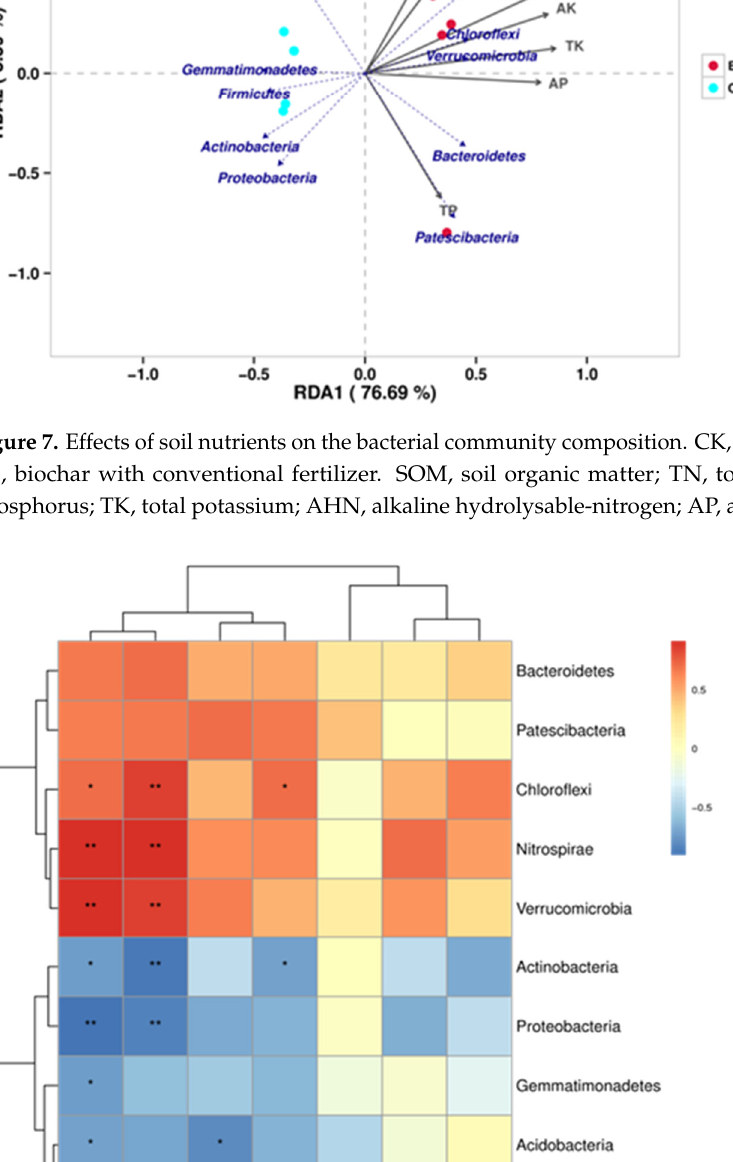
Figure 8. Correlation analysis of soil nutrients and bacterial community structure. SOM, soil organic matter; TN, total nitrogen; TP, total phosphorus; TK, total potassium; AHN, alkaline hydrolyzable- nitrogen; AP, available phosphorus; AK, available potassium. * Significance at p < 0.05. ** Significance at p < 0.01.